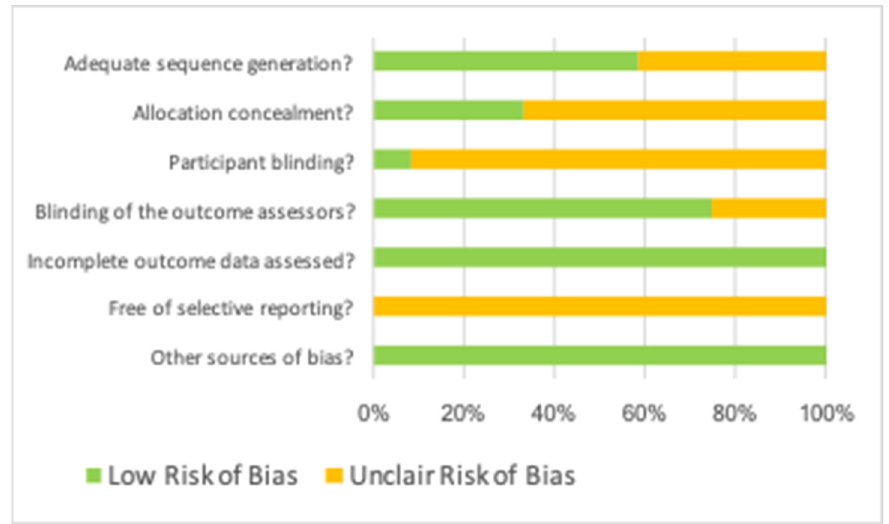
Figure 1. Risk of bias. Green color means “low risk of bias”, and yellow color means “unclair risk of bias”.